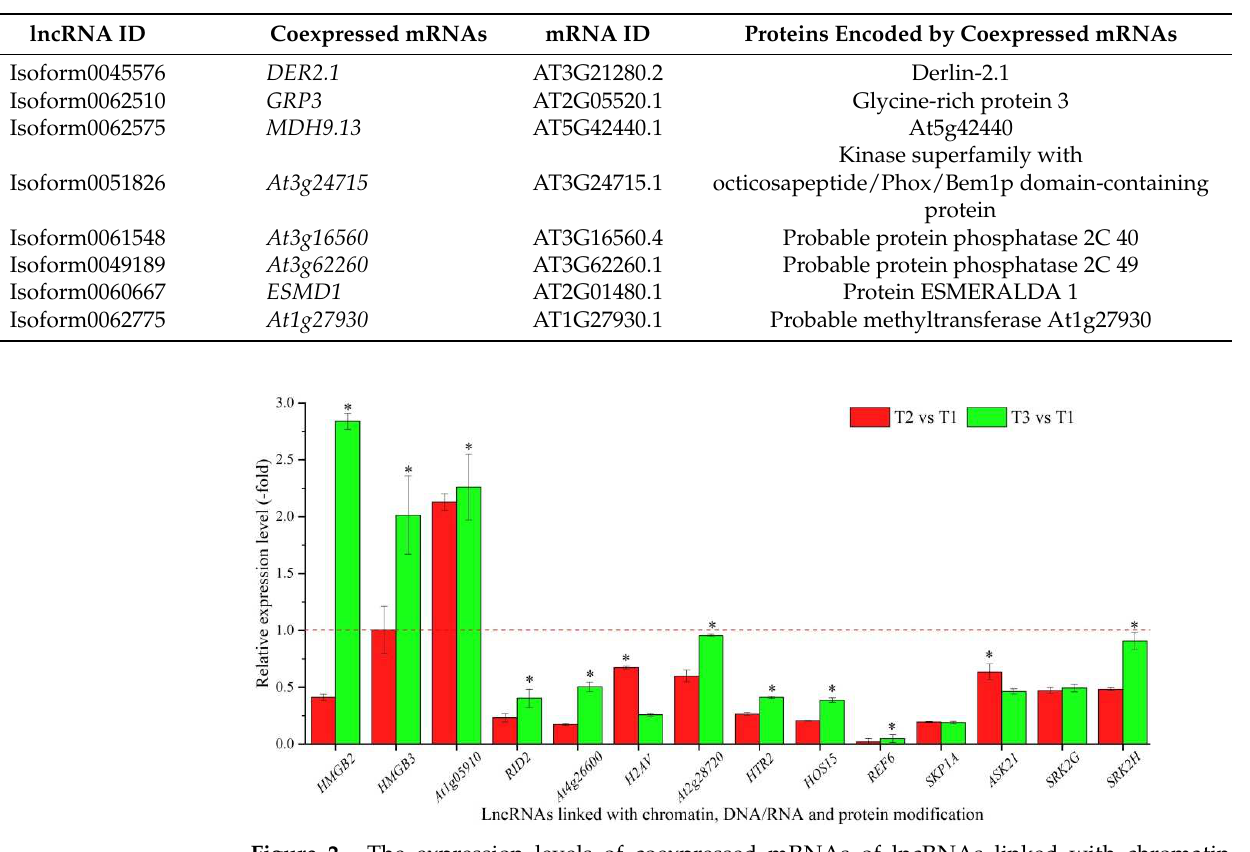
Figure 2. The expression levels of coexpressed mRNAs of lncRNAs linked with chromatin, DNA/RNA and protein modification in A. sinensis at T2 vs. T1 and T3 vs. T1, as determined by qRT-PCR. T1, T2, and T3 represent uncompleted, completed, and avoided vernalization, respec- tively. The “*” represents a significant difference at p < 0.05 level between T2 vs. T1 and T3 vs. T2 for the same gene.